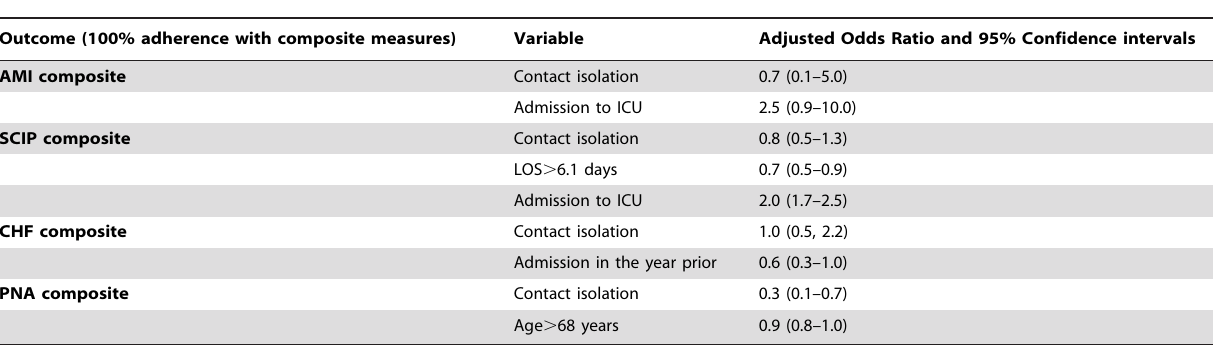
Table 3. Logistic regression models for each composite outcome